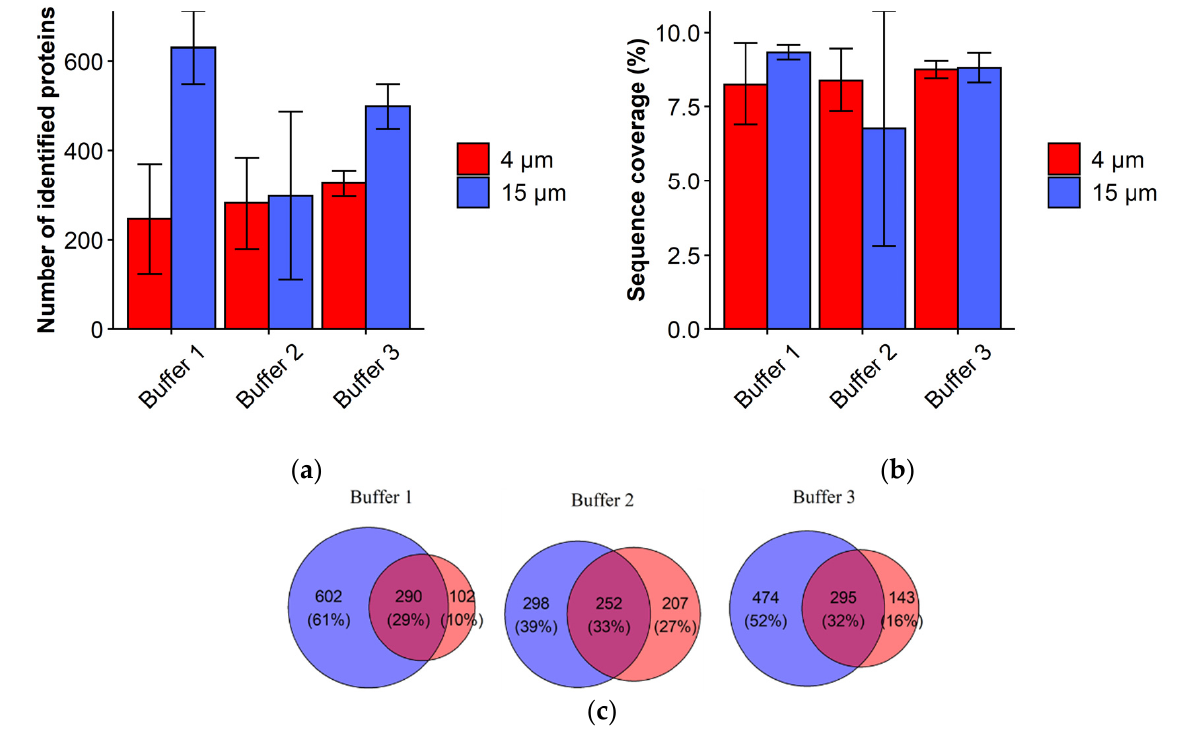
Figure 2. Qualitative and quantitative comparison of the proteins extracted from 4 and 15 μ m thick FF tissue using Buffers 1 to 3. ( a ) Number of identified proteins; ( b ) Sequence coverage; ( c ) Venn diagrams illustrating the distribution of all identified proteins between 15 μ m (blue) and 4 μ m (red) thick FF tissue. Results are shown as mean ± SD.